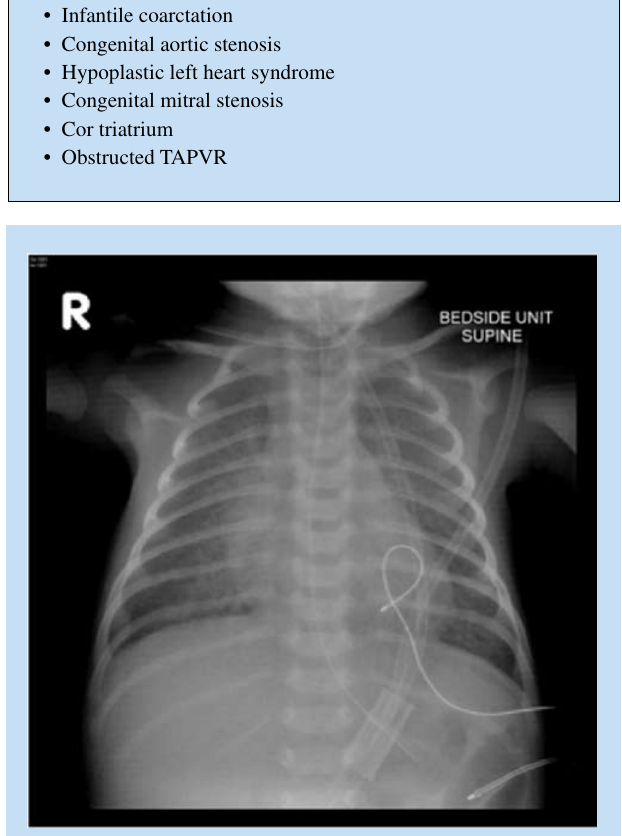
Fig. 1. Chest radiograph of the patient showing evidence of severe pulmonary venous congestion with a normal cardiothoracic